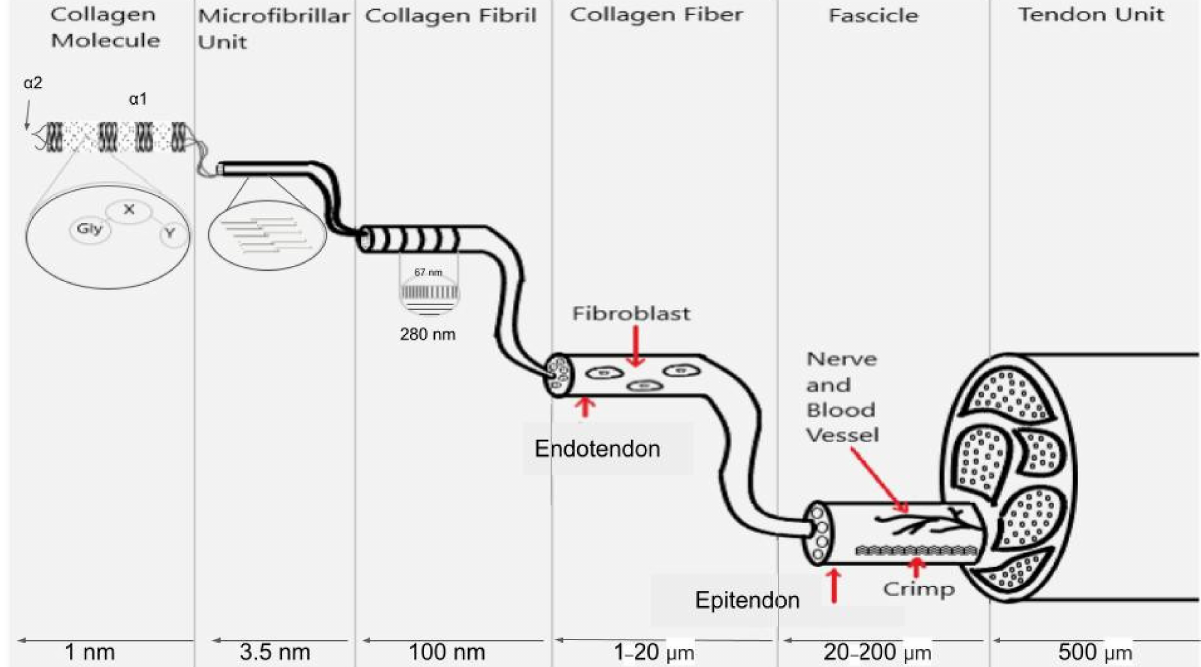
Figure 1. Illustration showing the molecular, microfibrillar, fibrillar and fascicular structure of tendon. Collagen molecules are composed of flexible Gly-X-Y (light regions on left of collagen molecule) sequences that alternate with rigid sequences of Gly-Pro-Hyp (dark regions of collagen molecule) that make a triple helix that is a hybrid of flexible and rigid mechanical elements. The microfibril is composed of 5 quarter-staggered collagen molecules with all the flexible and rigid regions in register. The 67 nm repeat period (D period in tendon) occurs at the fibrillar level when observed in the electron microscope and has all the flexible and rigid regions laterally aligned. Fibroblasts form longitudinal columns of cells on the surface of collagen fibrils. Collagen fibers are made up of laterally fused collagen fibrils and are wrapped with an ECM termed endotendon. Collagen fibers form fascicles and are bound into tendon units by additional ECM termed epitendon. The flexibility of collagen molecules is preserved in the D period of collagen fibrils and fibers and provides the energy storage to the